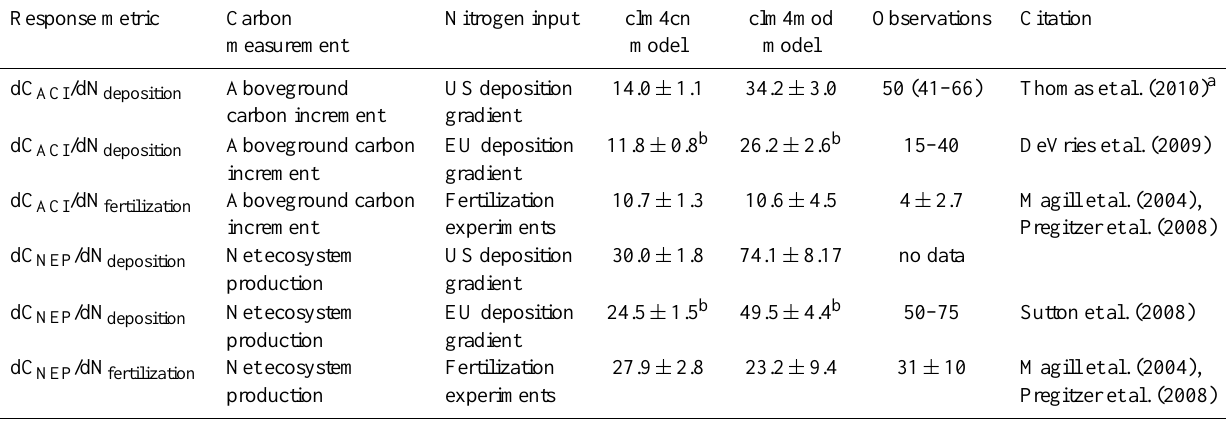
Table 3. Model simulations and observations of the vegetation and ecosystem carbon increment response to nitrogen deposition and fertil- ization. Model uncertainty estimates correspond to variation among sites (1S.E.). US = United States; EU =